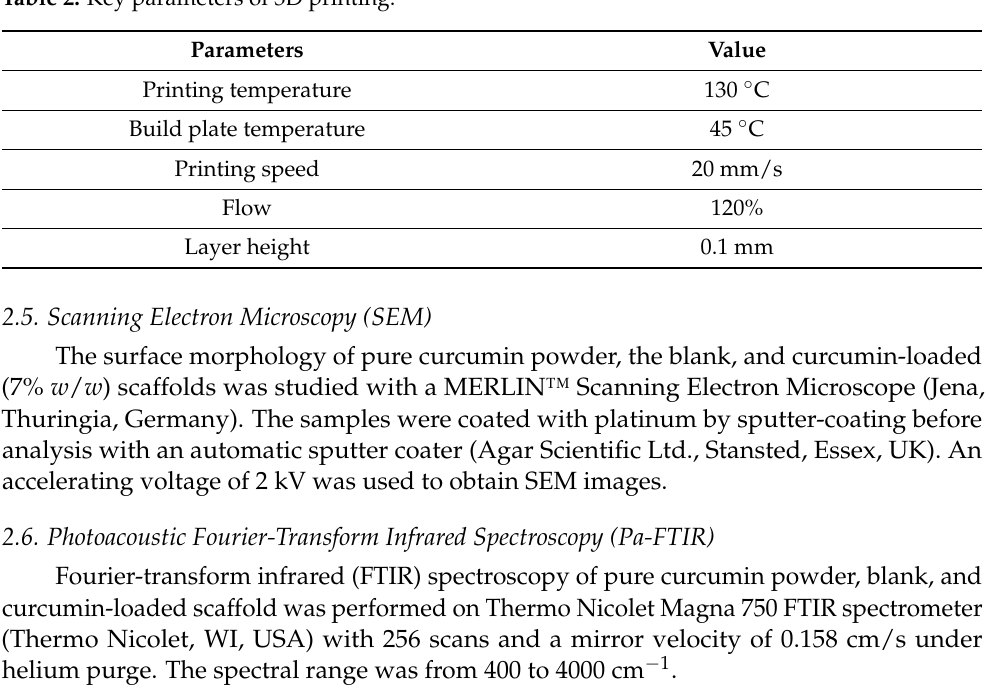
Table 2. Key parameters of 3D